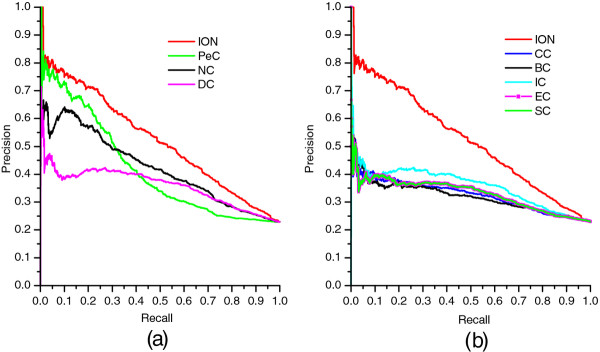
PR curves of ION and eight other existing centrality methods. The proteins ranked in top K (cut-off value) by each method (ION, DC, BC, CC, SC, EC, IC, NC and PeC) are selected as candidate essential proteins (positive data set) and the remaining proteins in PPI network are regarded as candidate nonessential proteins (negative data set). With different values of K selected, the values of precision and recall are computed for each method. The values of precision and recall are plotted in PR curves with different cut-off values. (a) shows the PR curves of ION, PeC, NC and DC. (b) shows the PR curves of ION and two global centrality methods: BC and CC, and other tree centrality methods: IC, EC and SC.